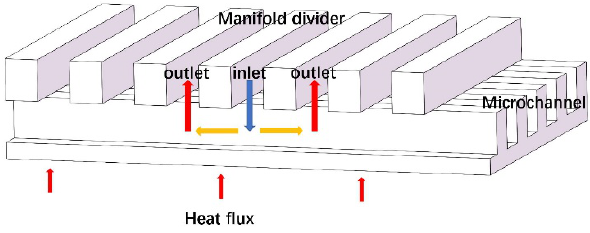
Figure 1. A schematic diagram of an ordinary MMC.